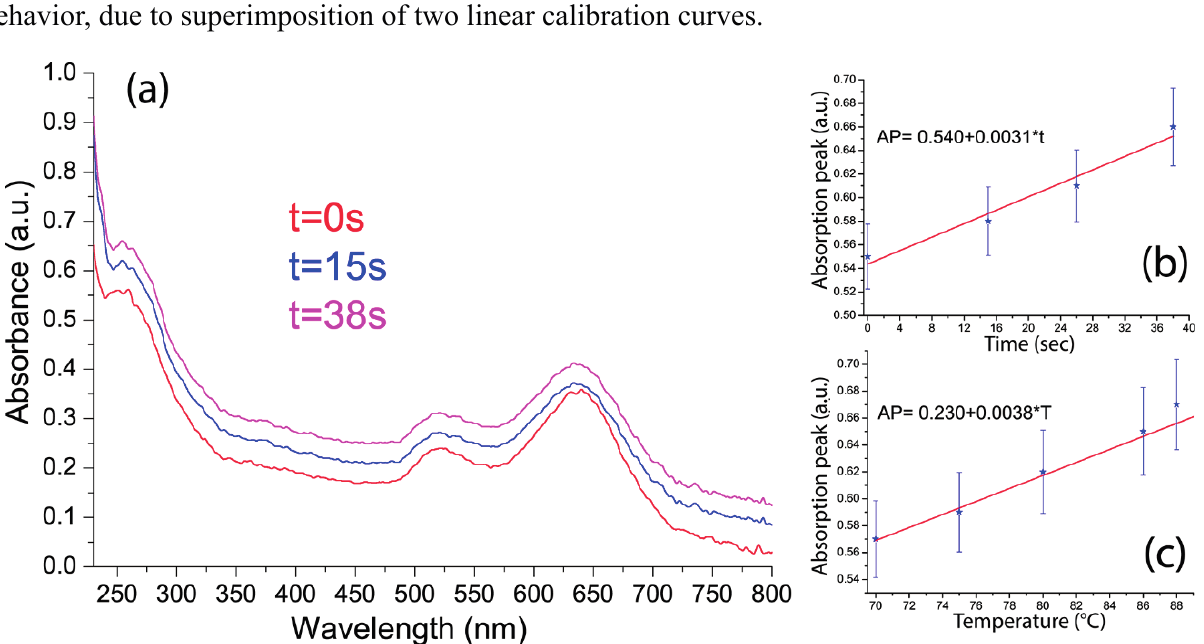
Figure 5. Absorption spectra of the sample for different values of the ( a ) illumination time; linear fit of the intensity of the DNA absorption peak (at λ = 260 nm) versus the ( b ) illumination time and ( c )